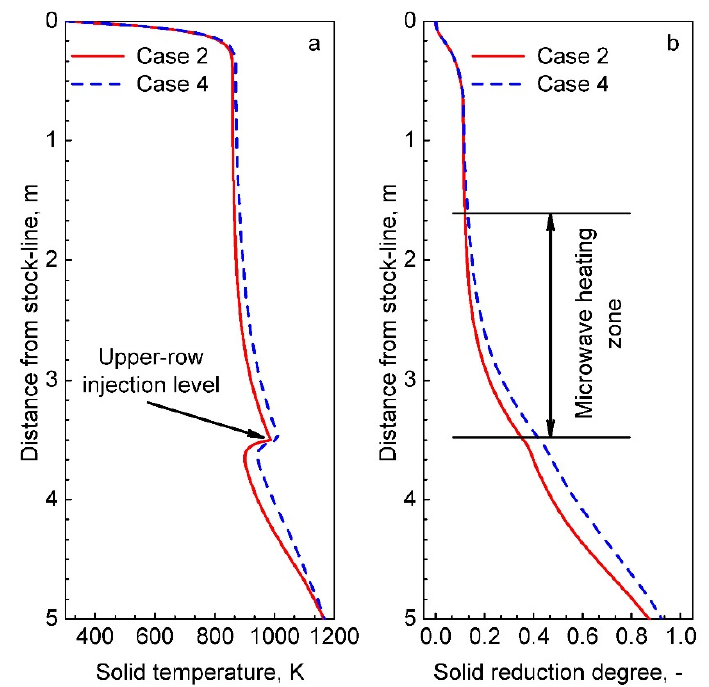
Figure 6. Effects of microwave heating (with E mw = 1.4 MW) on the distributions of solid temperature ( a ) and solid reduction degree ( b ).